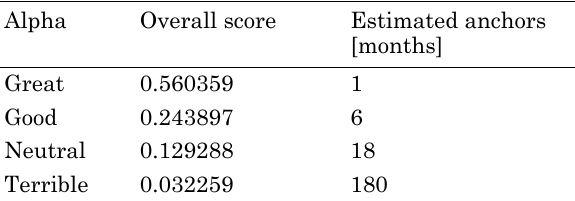
table 4. estimated anchors